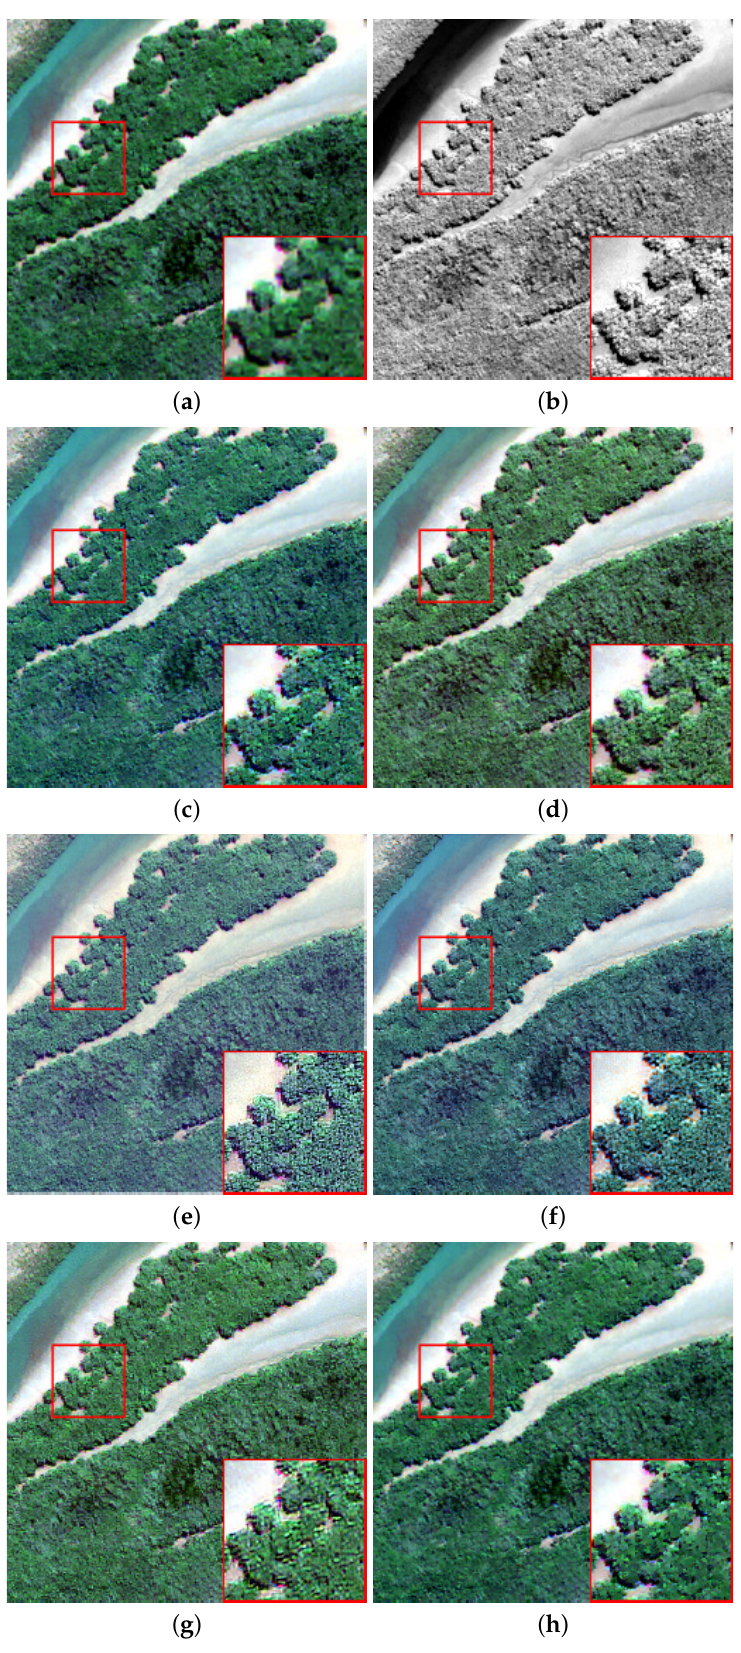
Figure 7. Fusion results of six different PS fusion methods in Worldview-4 data. ( a ) Upsampled